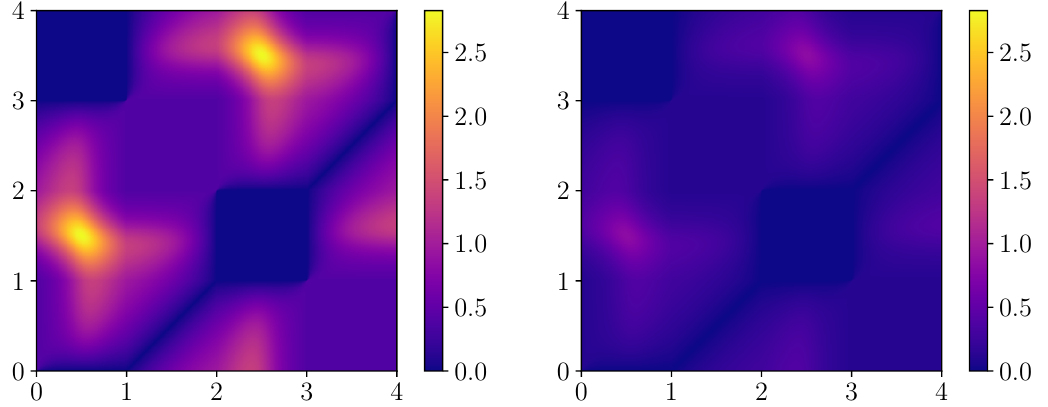
Figure 17 . The result from the linear wombling procedure described in the text on a data set with ρ = 5 (left) and ρ = 1 . 5 (right). The heat map is color coded according to the value of | ¯Γ[ C ] | and exhibits two degenerate maxima since each line is traversed twice (once in each